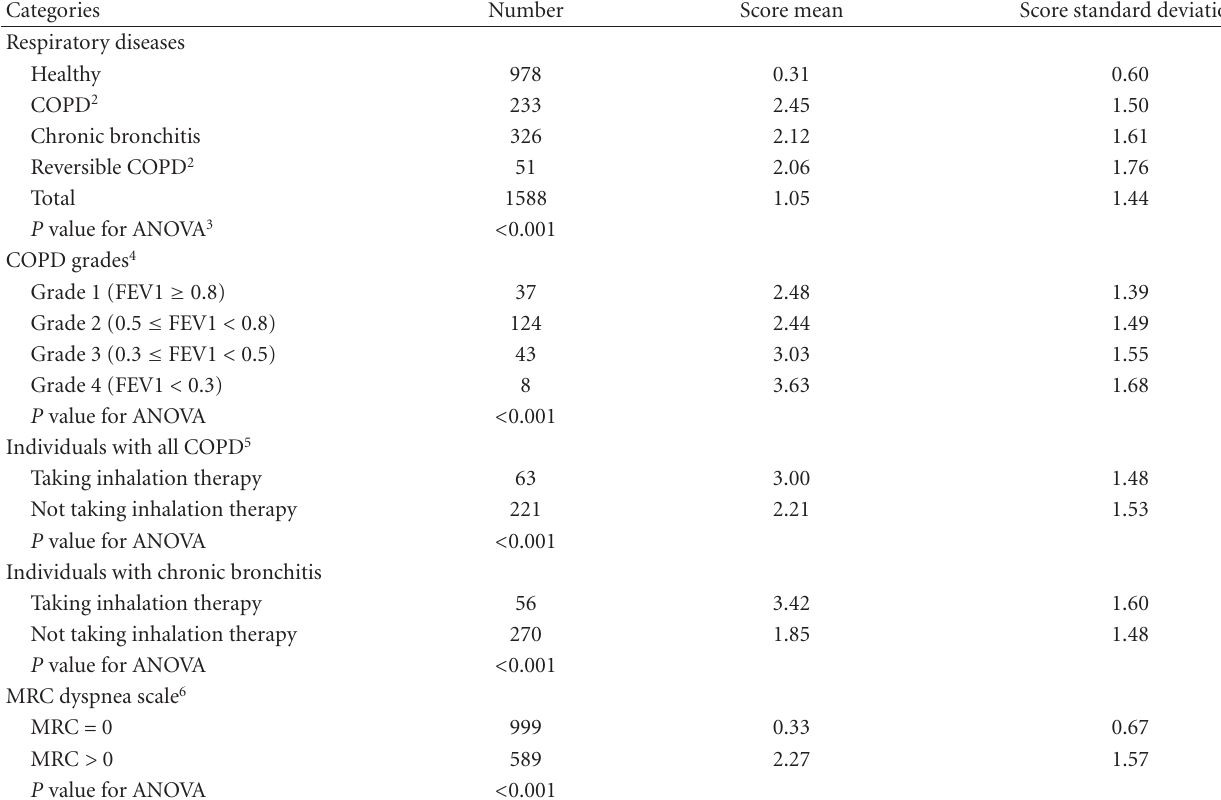
Table 3: Respiratory-related quality of life (CCQ 1 ) scores.